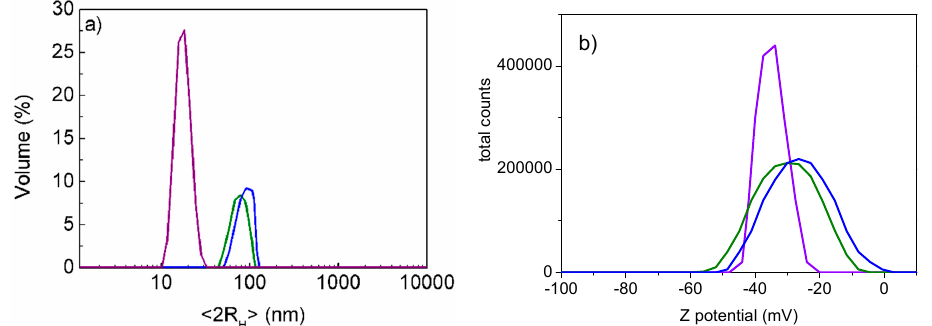
Figure 3. DLS data of AuNPs in violet, AuNPs-A in green and AuNPs-B in blue: ( a ) <2R H > in water: AuNPs (15 ± 2 nm), AuNPs-A (56 ± 30 nm) and AuNPs-B (76 ± 32 nm); ( b ) Z potential in water: AuNPs (–35 ± 2 mV), AuNPs-A (–30 ± 3 mV) and AuNPs-B (–23 ± 4 mV).